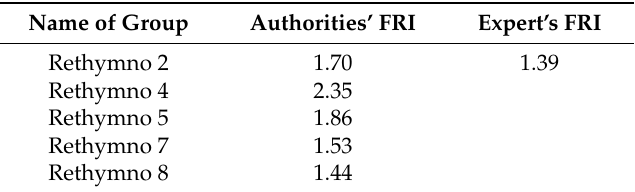
Table 3. FRI for the city scale of